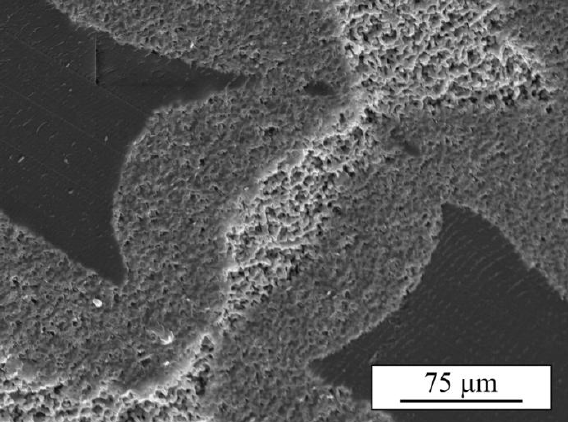
Figure 8. SEM micrograph showing the incomplete impregnation of rods on a TCP/PLA bending test